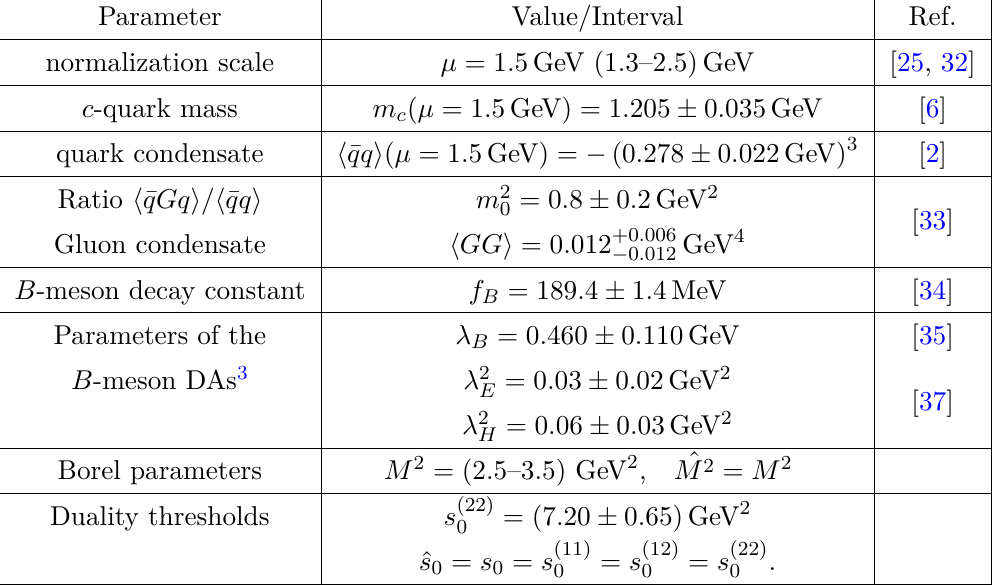
For the charmed meson channel this procedure was used, for example, in the LCSRs for the B → D ( ∗ ) form factors. Note that here, apart from the conventional axial